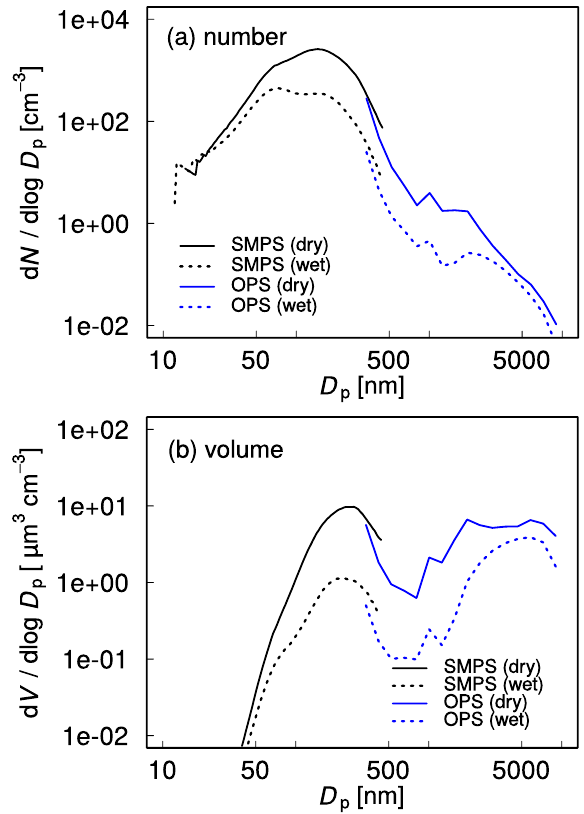
Figure 27. Median particle number (a) and volume (b) size distributions from the SMPS and OPS instruments, representa- tive for conditions during the wet (dashed lines) and dry (solid lines) seasons. Plotted data sets comprise continuous SMPS and OPS data covering 7-day periods for wet (6–13 May 2014) and dry (13–20 September 2014) season conditions. Inte- grated number and volume concentrations for the selected wet